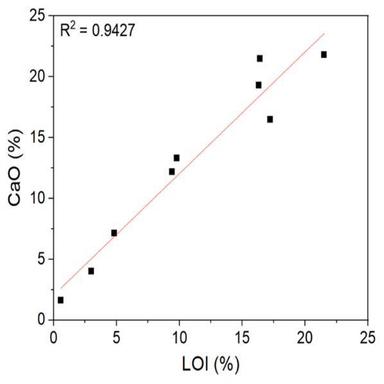
Correlation of CaO vs LOI.